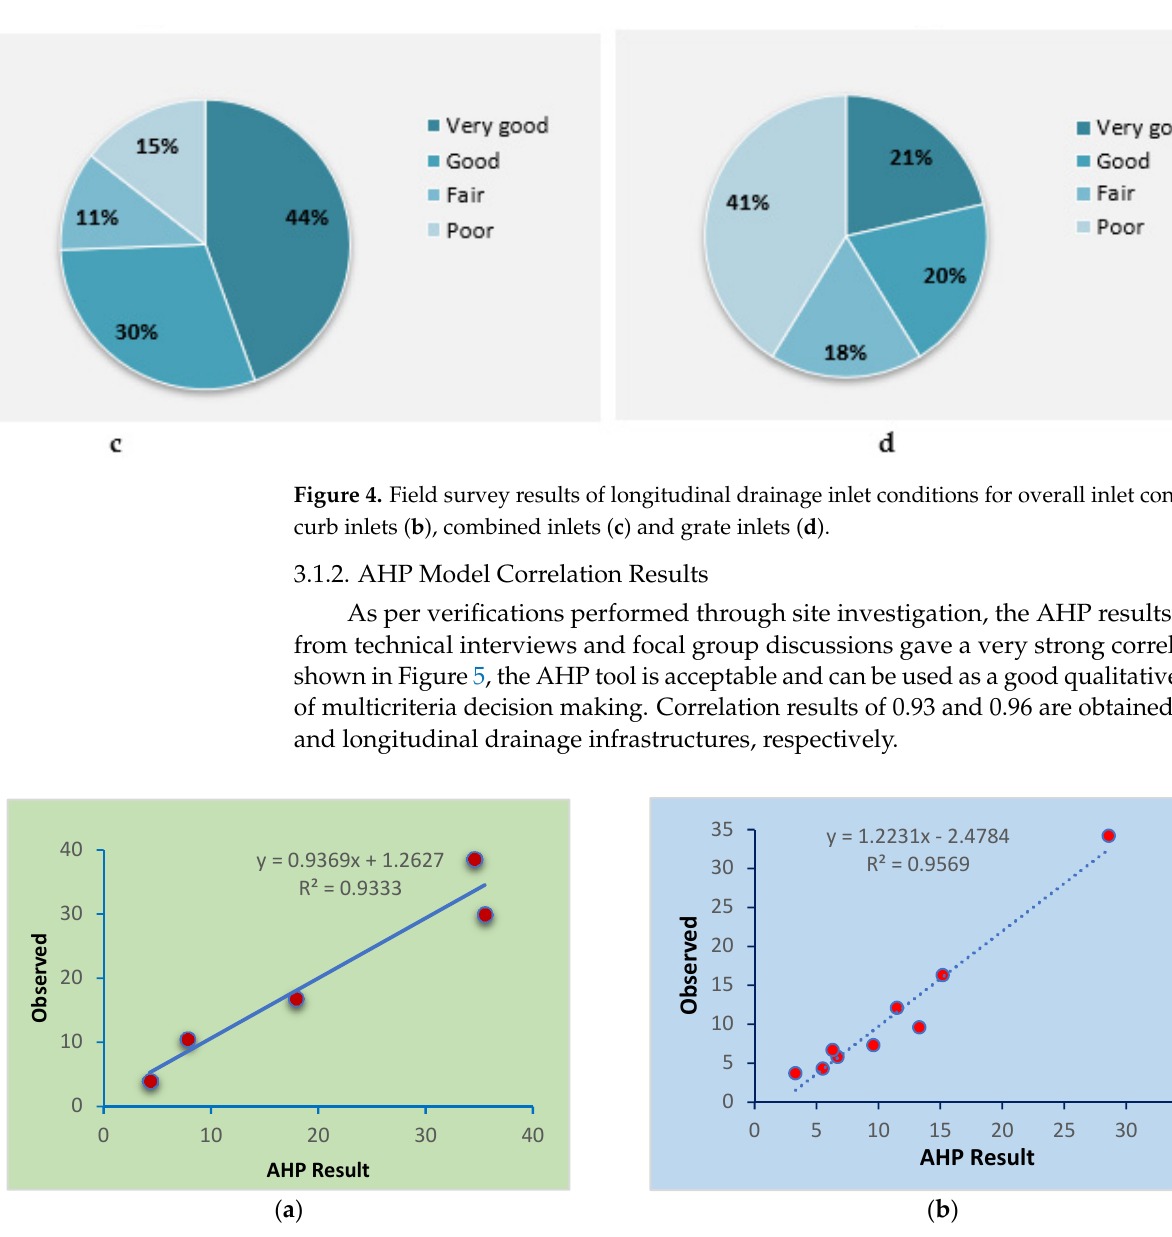
Figure 5. Correlation result of failure causes through site observation and AHP model results for cross–drainage ( a ) and longitudinal drainage ( b ) structures.